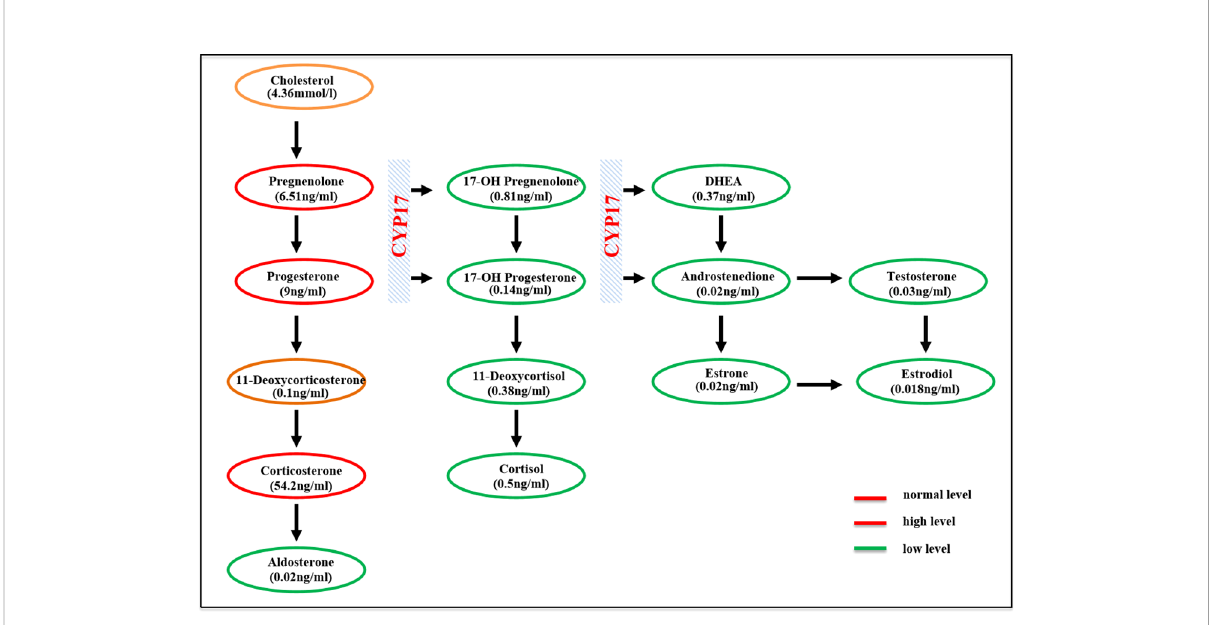
FIGURE 1 Schematic of the adrenal steroidogenesis pathway.